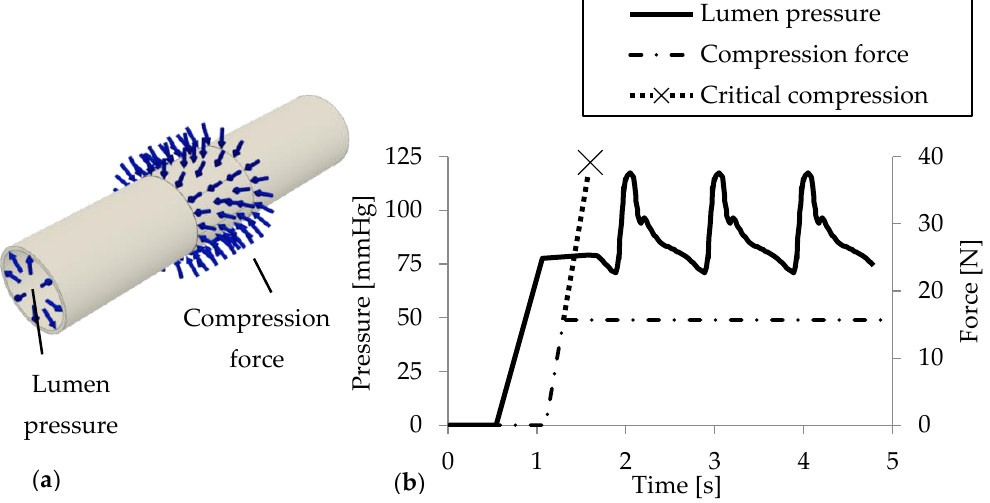
Figure 2. Aortic model with specified boundary conditions ( a ) and time-dependent lumen pressure load ( b ) [10].